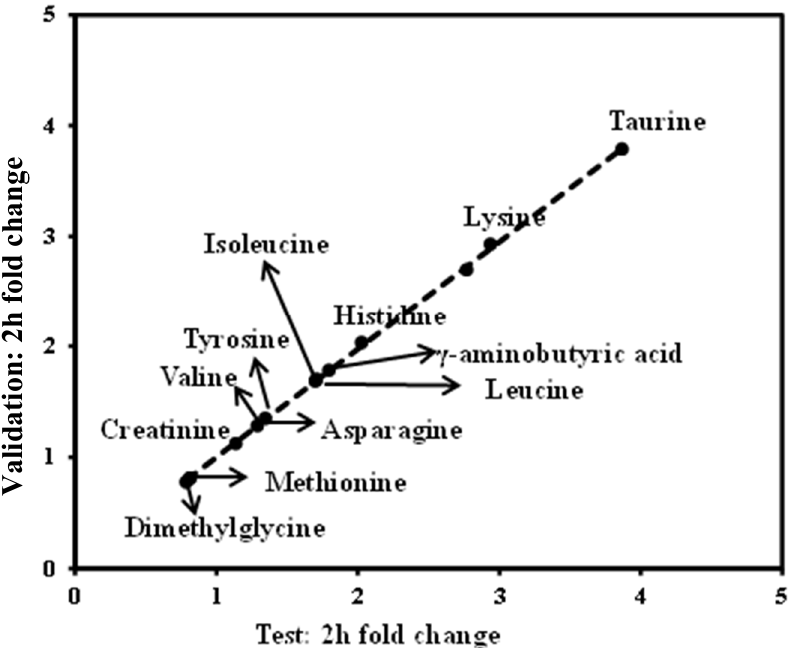
Figure 7. Validation of metabolite changes at the 2 ‐ h time point. In total, 13 metabolites that changed significantly in the test study (Figure 4) replicated ( p < 0.05) in the validation study. Dots correspond to the median fold change of metabolites at the 2 ‐ h time point. Fold changes for the metabolites (X) detected by UPLC ‐ TQ ‐ MS were calculated as follows: X Fold change = (X Concentration at 120 min /X Concentration at baseline ). The arrows indicate the metabolisms in the test and validation set.